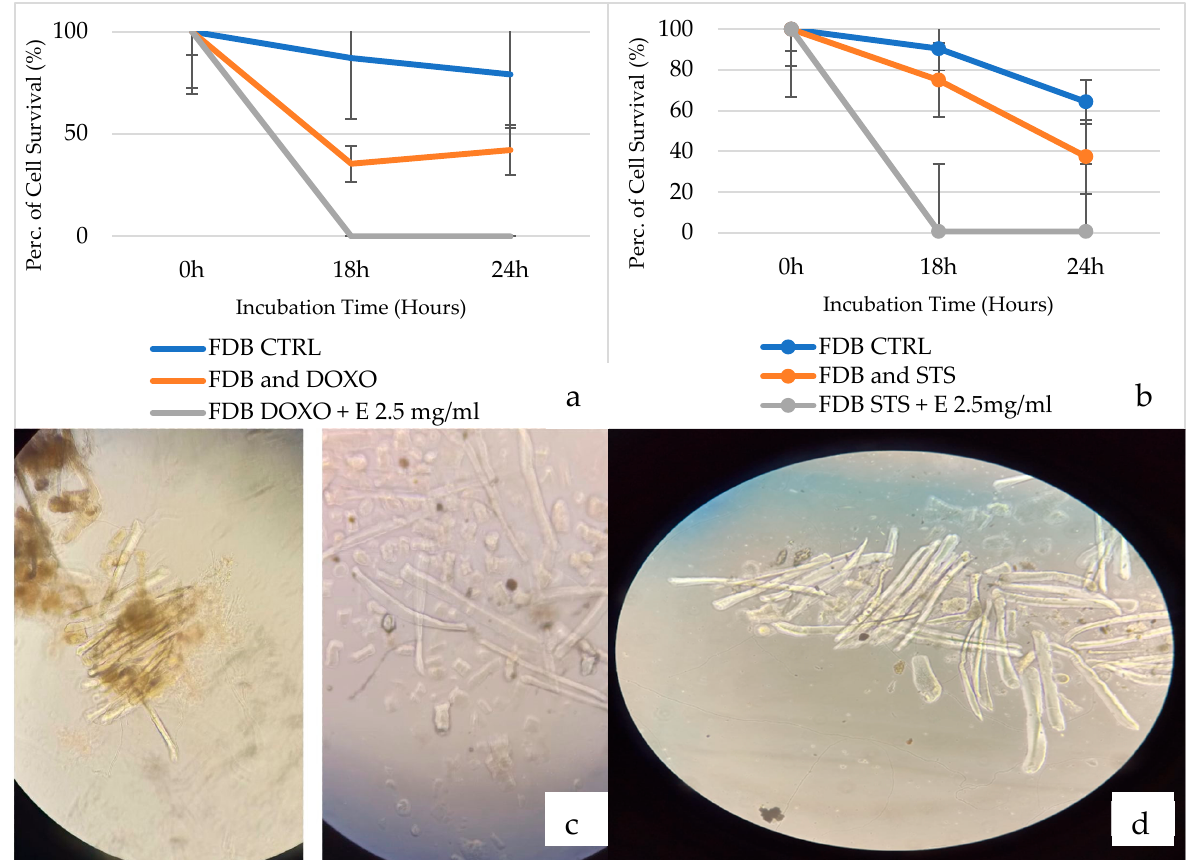
Figure 6. ( a ) Cell survival rate at different incubation times (18 h and 24 h) of mouse Flexor digitoturum brevis (FDB) muscle fibers treated with doxorubicin (DOXO) and with doxorubicin associated with the acetonitrile–water extract E (2.5 mg/mL) (N experiments = 3). ( b ) Cell survival rate at different incubation times (18 h and 24 h) of mouse FDB treated with staurosporine (STS) and with staurosporine associated with acetonitrile–water extract E (2.5 mg/mL) (N = 3 experiments). ( c ) On the left, an evaluation of FDB fiber survival after an incubation time of 18 h with staurosporine (STS) (2.14 × 10 − 6 M). On the right is an evaluation of FDB fiber survival after an incubation time of 18 h with doxorubicin (1 × 10 − 6 M). The fiber survival was evaluated by direct visual inspection and cell counting under Zeiss Axiovert 10 inverted microscope (×10). For each fiber, three individual measurements were performed at three or two different points. The appearance of multiple sarcolemma blebs often preceded cellular death. ( d ) Sample of untreated muscle fibers used as a control after 18 h of incubation time.